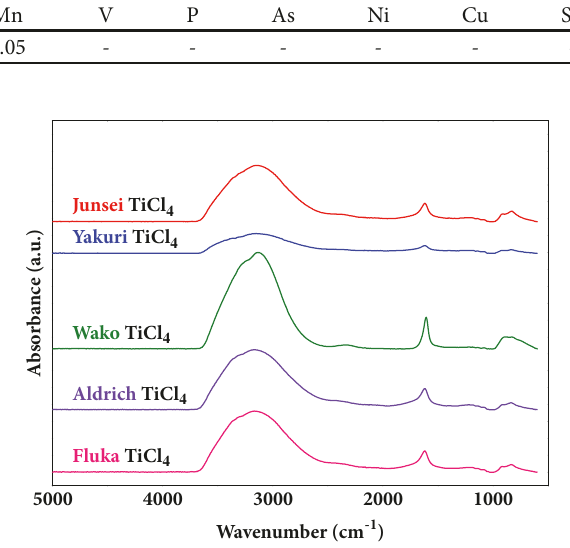
Figure 2: The effect of various hydrochloric acid concentrations for the qualitative analysis of titanium tetrachloride.